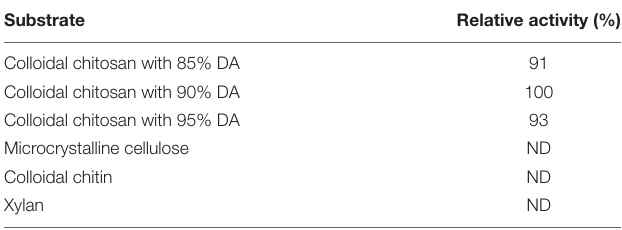
TABLE 1 | The substrate specificity of